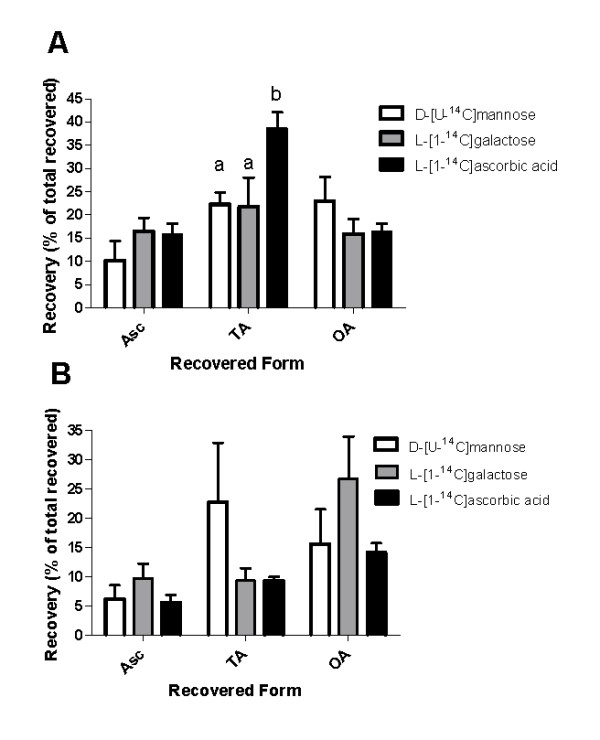
Recovery of 14C-labeled products in grapevine tissue after infiltration of 14C-labeled precursors to the excised bunch stem. Two-way ANOVA with Bonferroni Post-test was performed using GraphPad Prism 5.01 (San Diego, California). The mean values with different letters above the SEM bars indicate significant differences between the proportions of radiolabelled substrates recovered in a specific product (P < 0.05). V. vinifera c.v. Shiraz bunches with 3 cm rachis attached were collected at 32 DAF. Data is presented as recovery of each 14C-labeled form in either the berry or rachis/stem as a percent of that same 14C-labeled form recovered in all tissues. n = 4, SEM bars. A. Recovery of 14C-labeled products in the berries and B. Recovery of 14C-labeled products in the combined rachis and stem tissue.